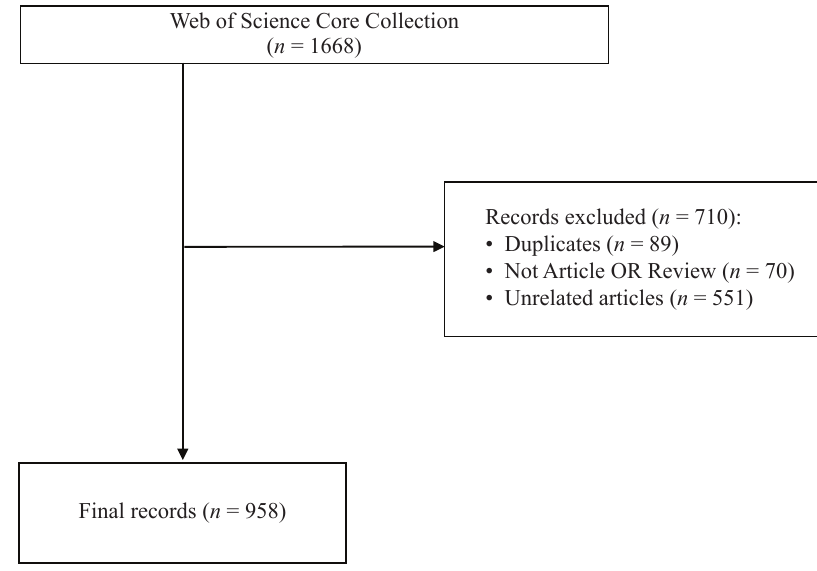
Figure 1. The flow diagram of illustrating literature search and